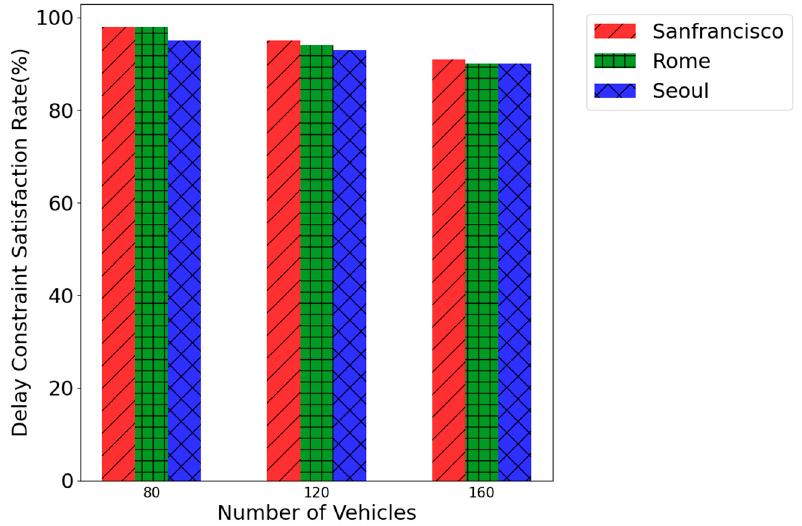
Figure 5. Delay constraint satisfaction rate with varying number of vehicles in different environments.